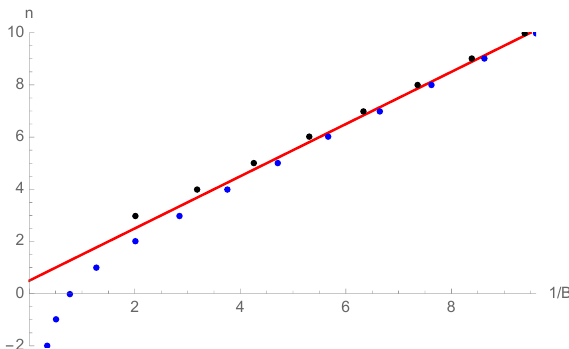
Figure 8: Sketch of a Landau plot or a Landau fan diagram analysis: the index n used to label maxima in the magneto-conductance are plotted as a function of the inverse magnetic field 1 / B (blue dots). A linear fit to the low field behavior is shown as a full red line. Deviation from linearity at high field are clearly visible. For this sketch, we used n = 1 / B + 1 / 2 − B for the blue dots, n = 1 / B + 1 / 2 + B for the black dots and n = 1 / B + 1 / 2 for the red line [ here B is a dimensionless magnetic field ] . The sign of the curvature term in the Landau plot n = function ( 1 / B ) is given by that of χ (cid:48) . The slope gives F = 1 and the intercept at 1 / B = 0 0 = 1 / gives − γ 0